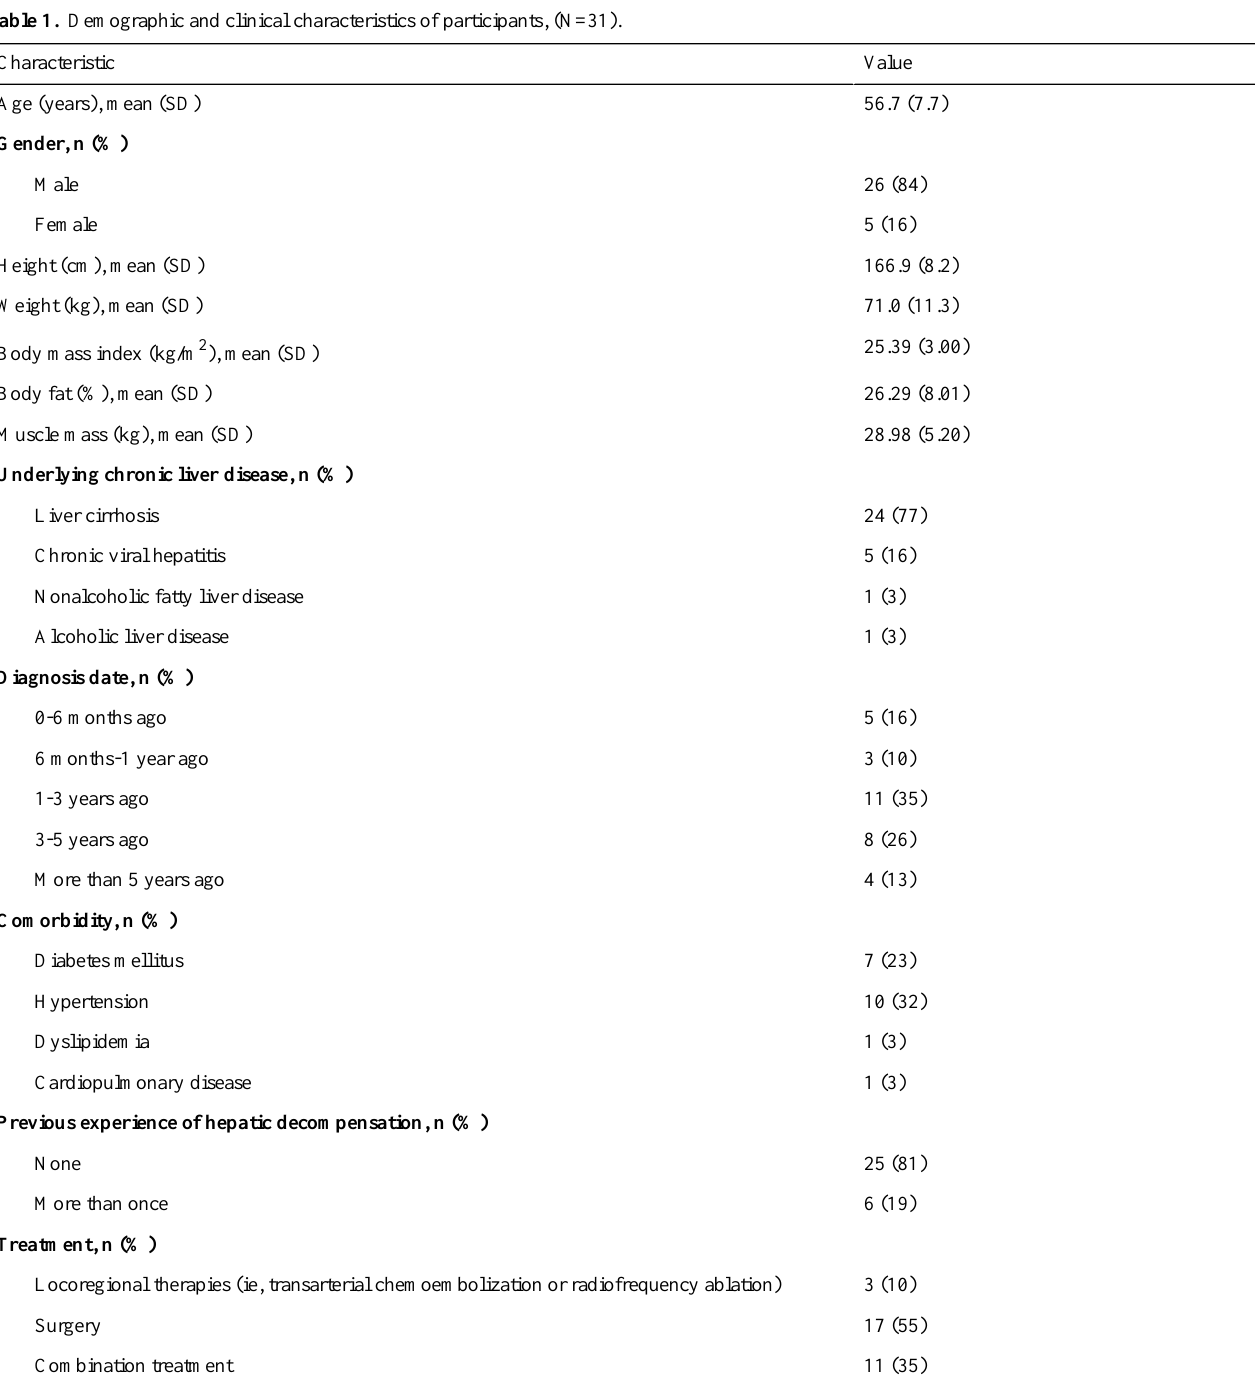
Table 1. Demographic and clinical characteristics of participants,